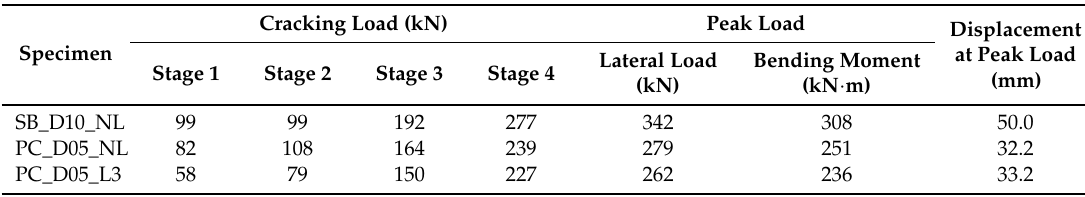
Table 3. Summary of the test results.